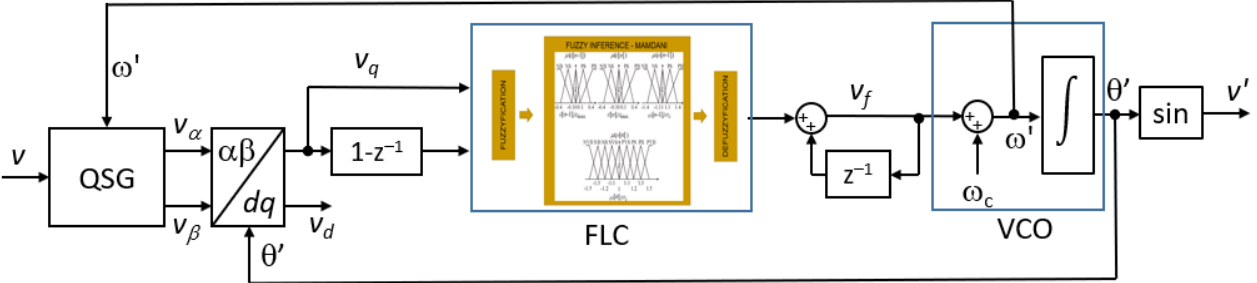
Figure 3. The control system structure: MPPT and boost control, DC-link and grid current control, synchronization block (SYNC).